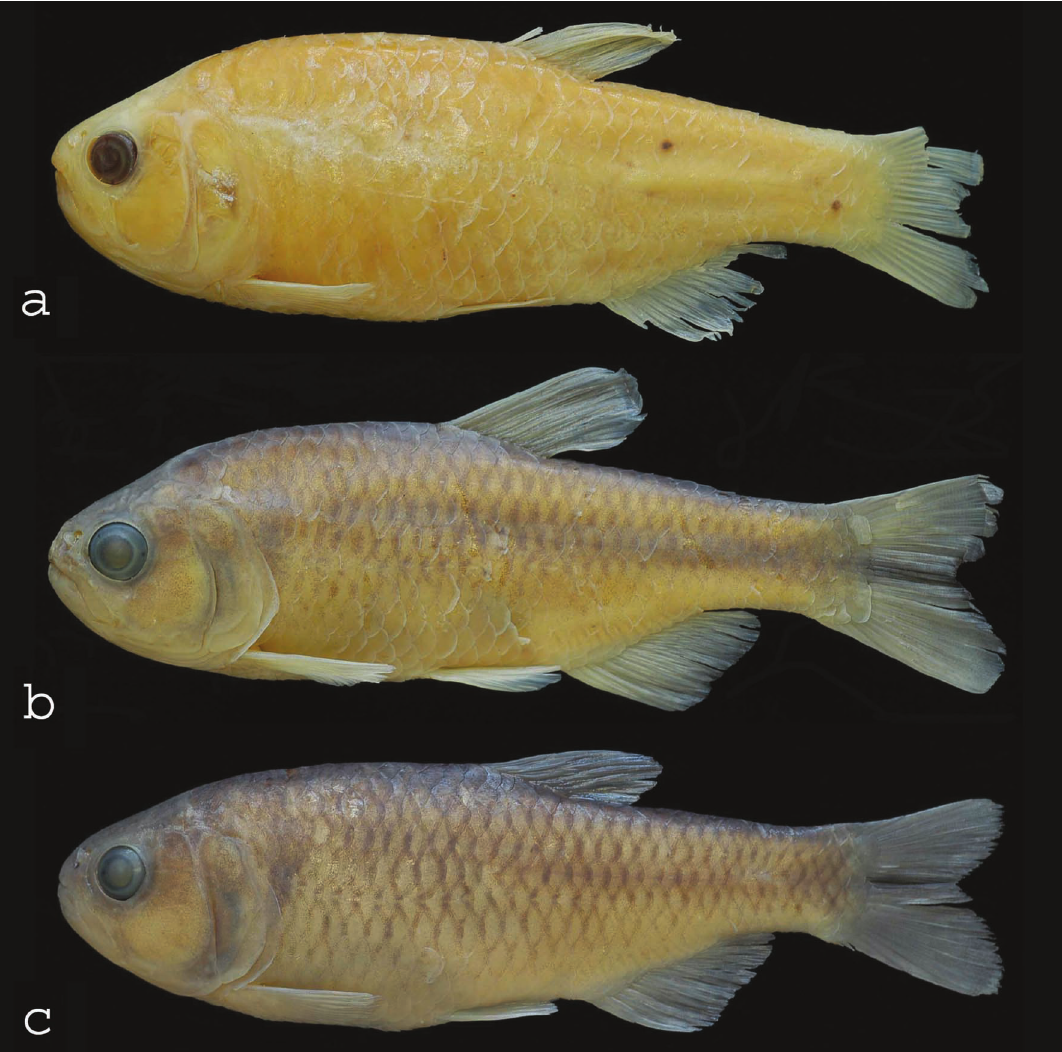
Fig. 4. Hasemania crenuchoides , all from Brazil, Distrito Federal, rio Paranaíba system, upper rio Paraná basin: (a) holotype, MZUSP 52732, male, 63.7 mm SL, córrego Planaltina, rio São Bartolomeu, rio Corumbá drainage; (b) DZSJRP 11039, female, 57.9 mm SL, córrego Paranoazinho, tributary of rio Sobradinho, rio São Bartolomeu basin. rio Maranhão system, rio Tocantins basin; (c) DZSJRP 14185, female, 64.5 mm SL, ribeirão da Contagem, Contagem Biological